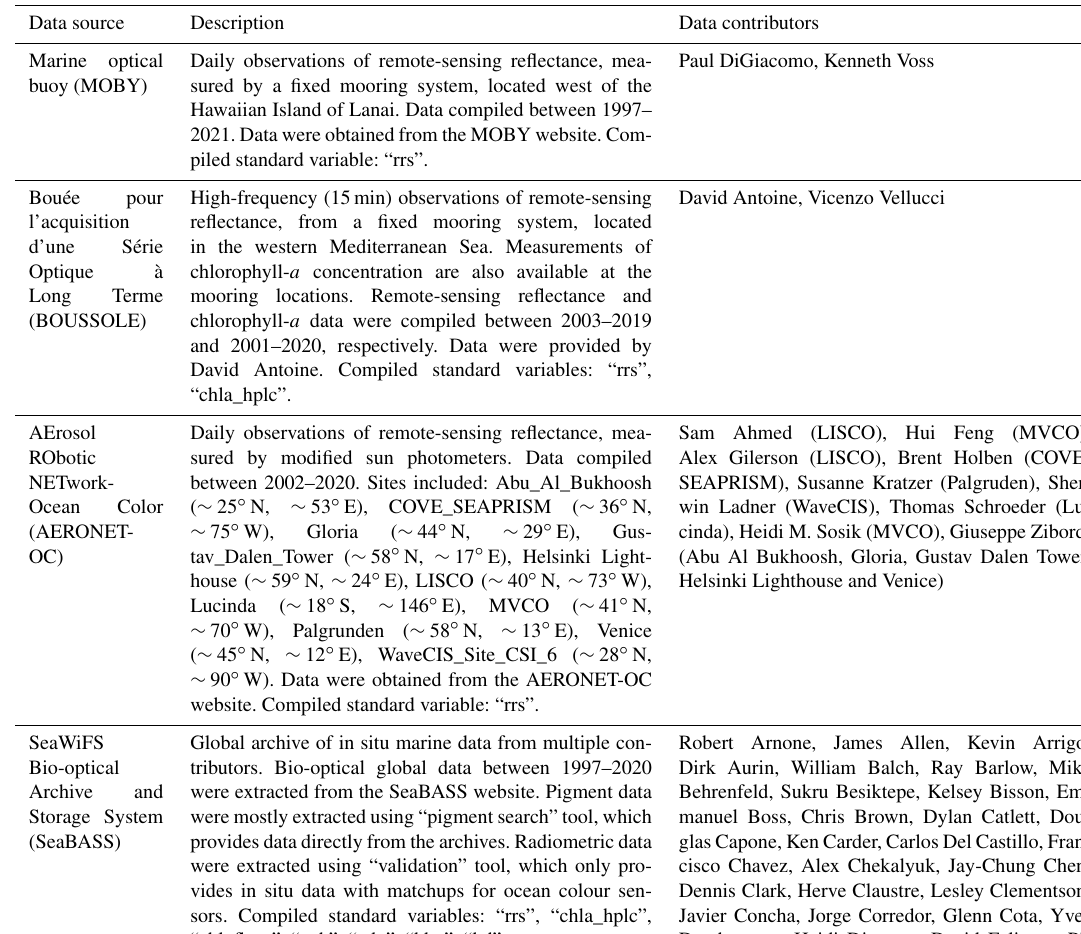
Table 2. Original sets of data and data contributors in the final table. Data